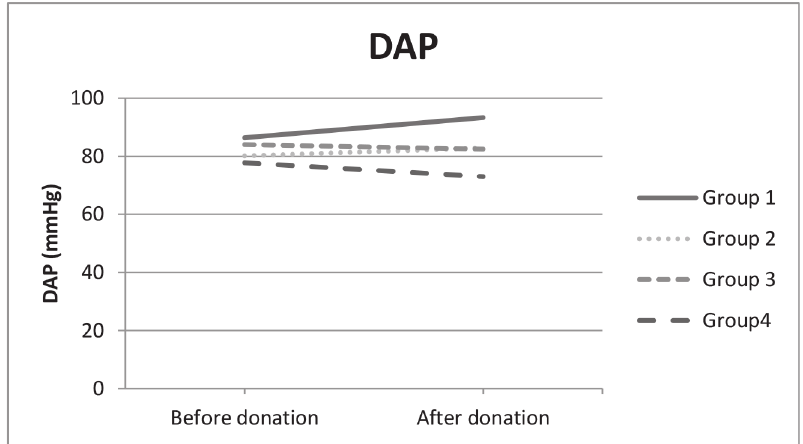
Figure 3 - Mean DAP values evidenced before and after the blood collection in each